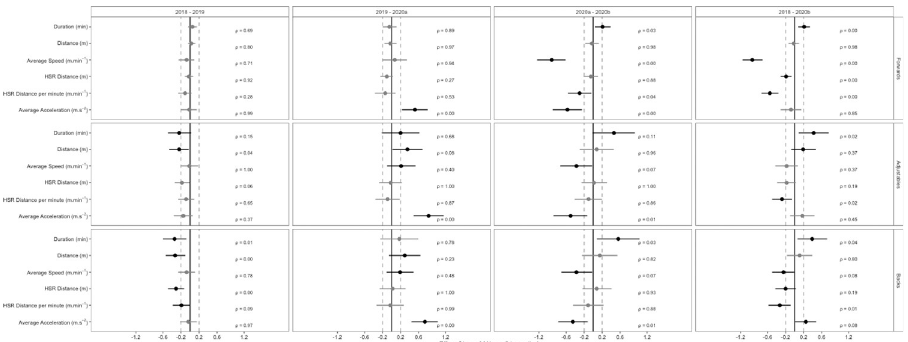
Fig 3. Standardised effect size ( ± 90% confidence interval) differences in BIP duration and locomotor characteristics between SL seasons 2018 to 2020 b